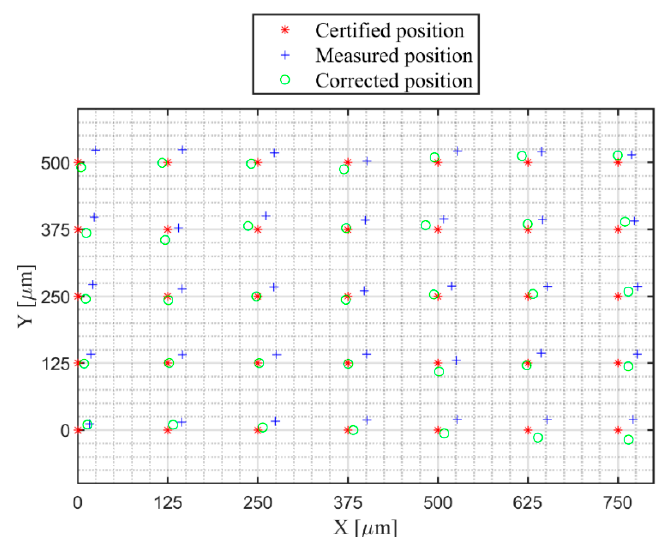
Figure 19. Comparison of the squared residuals before correction and after correction.